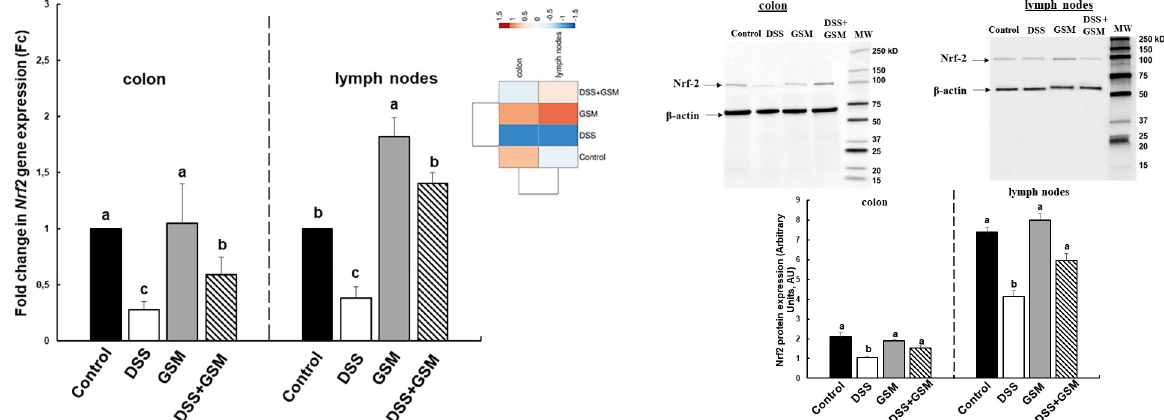
Fig 7. Expression of Nrf2 gene (A) and protein (B) in colon and mesenteric lymph nodes under DSS and GSM action. Unchallenged and DSS- treated pigs were assigned for 30 days to a Control diet (Control and DSS groups) or 8% GSM diet (GSM and DSS + GSM groups). At the end of the experiment, colon and mesenteric lymph nodes samples from all animals (n = 5) were collected. (A) The Nrf2 gene expression was analysed by qPCR and expressed as Fc. Results are presented as means ± standard errors. (B). The Nrf2 protein expression levels were expressed as arbitrary units (A.U.) as means ± standard errors of the mean (SEM). a, b, c Histograms for each group with unlike superscript letters were significantly different ( p < 0.050).